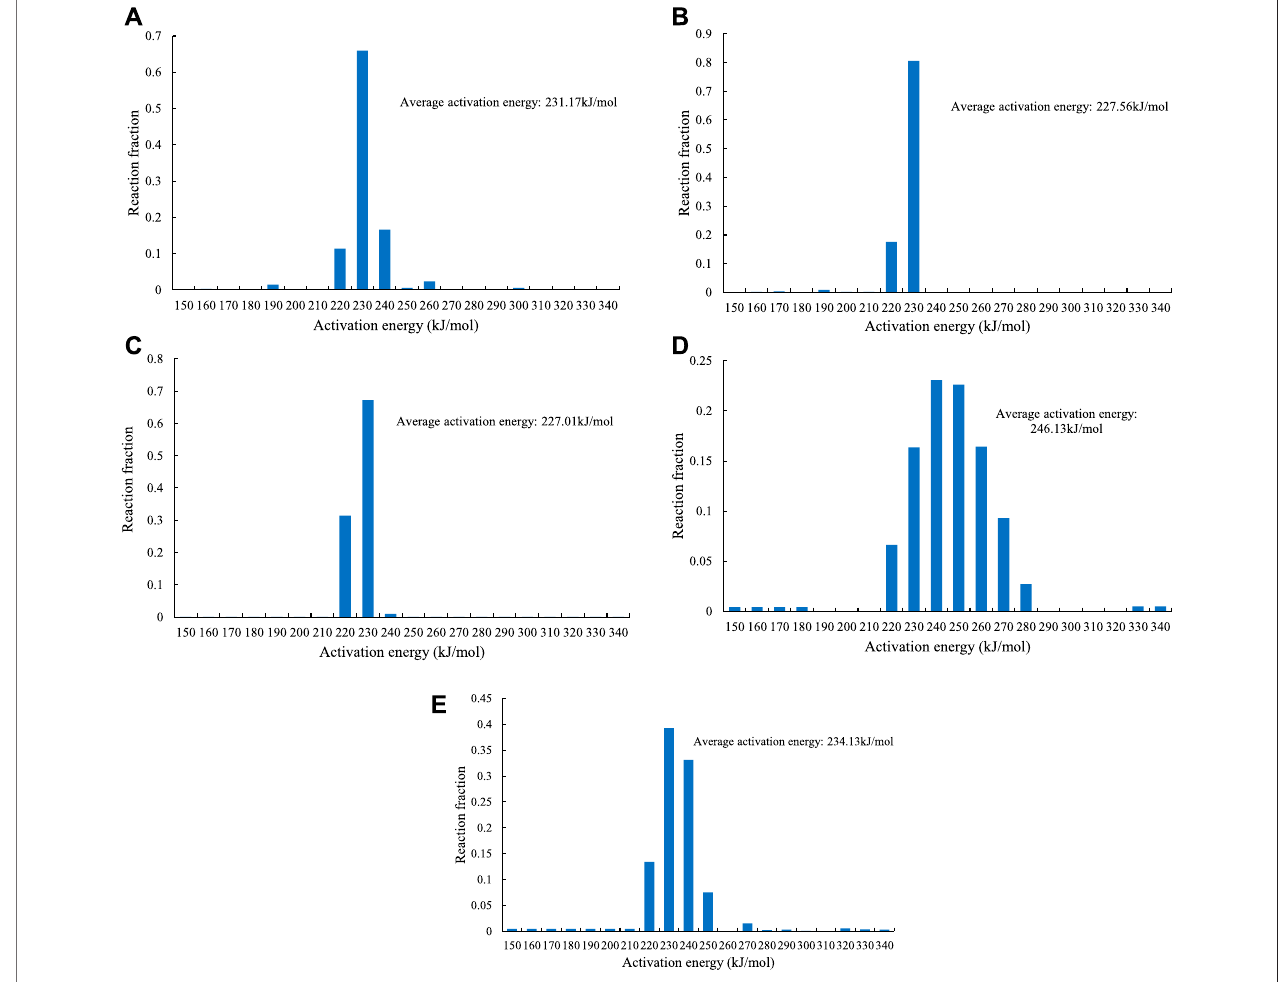
FIGURE 10 | The activation energy distribution of hydrocarbon generation from the pyrolysis of sample No. 9. (A) C 1 – 5 generation in the open system. (B) generationofC